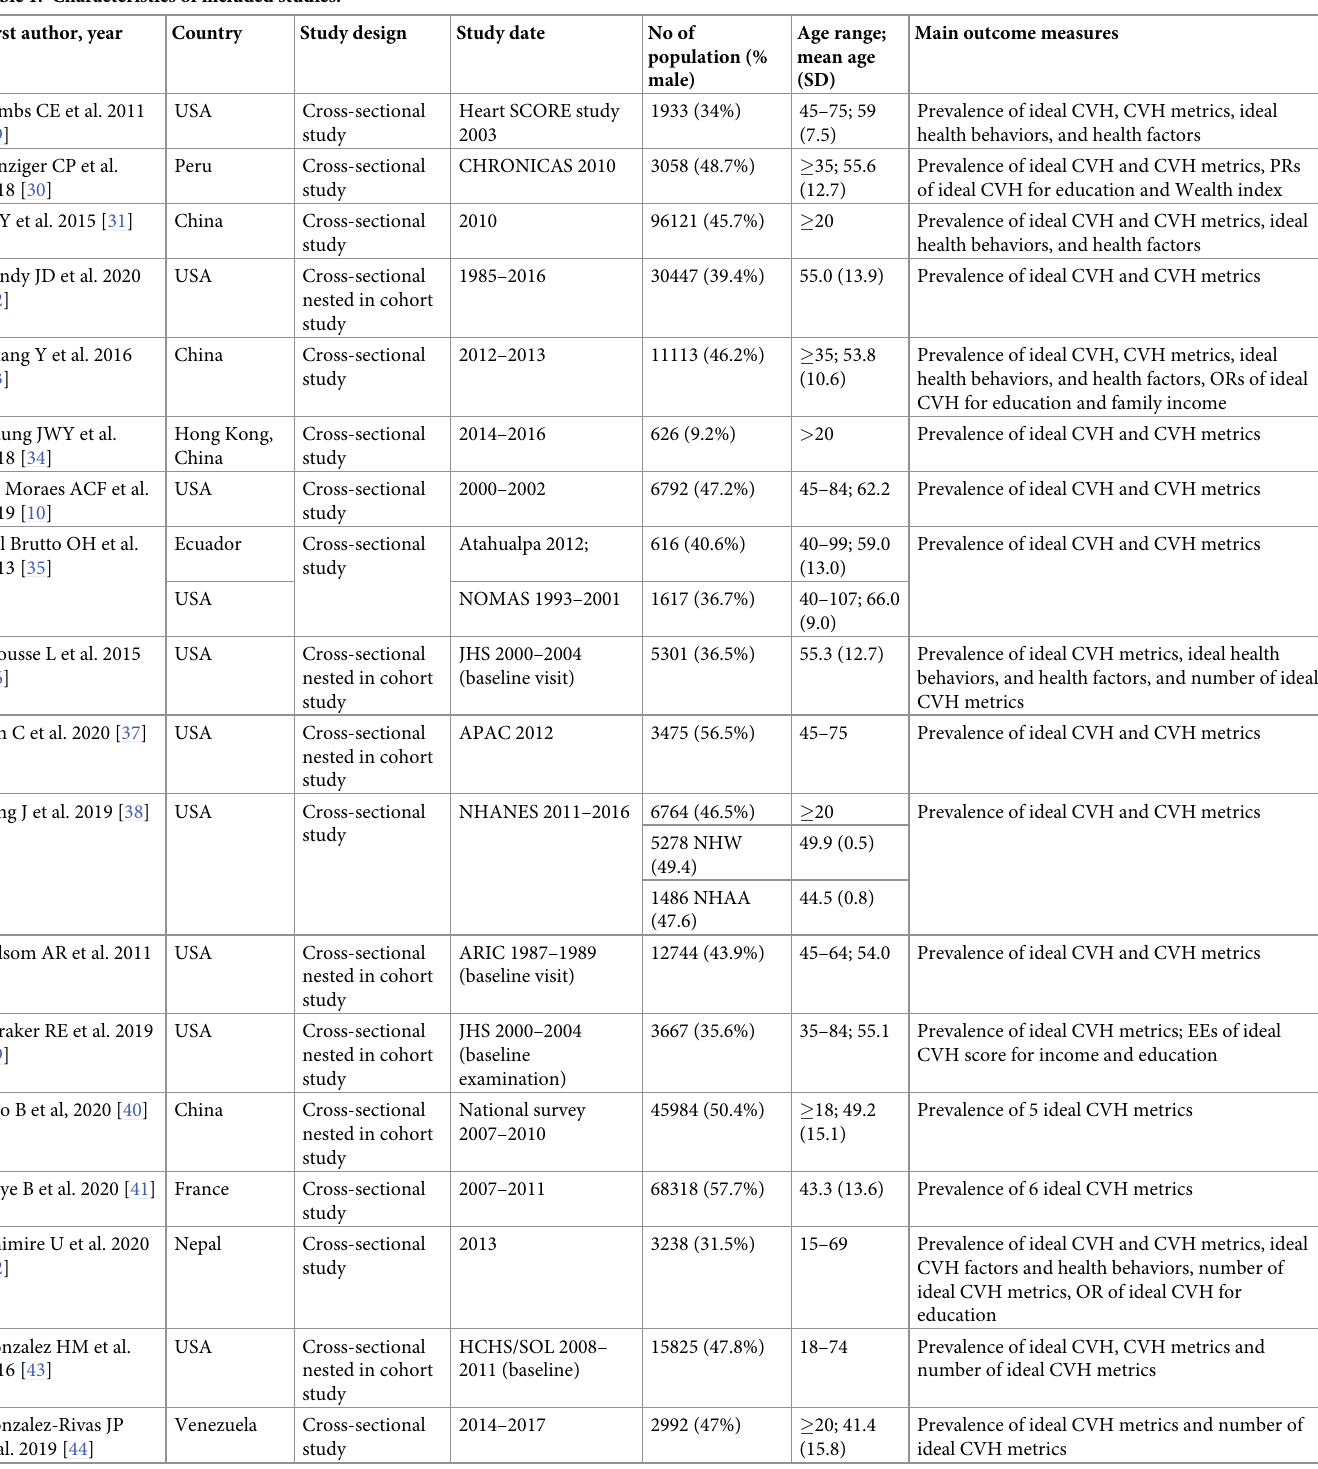
Table 1. Characteristics of included